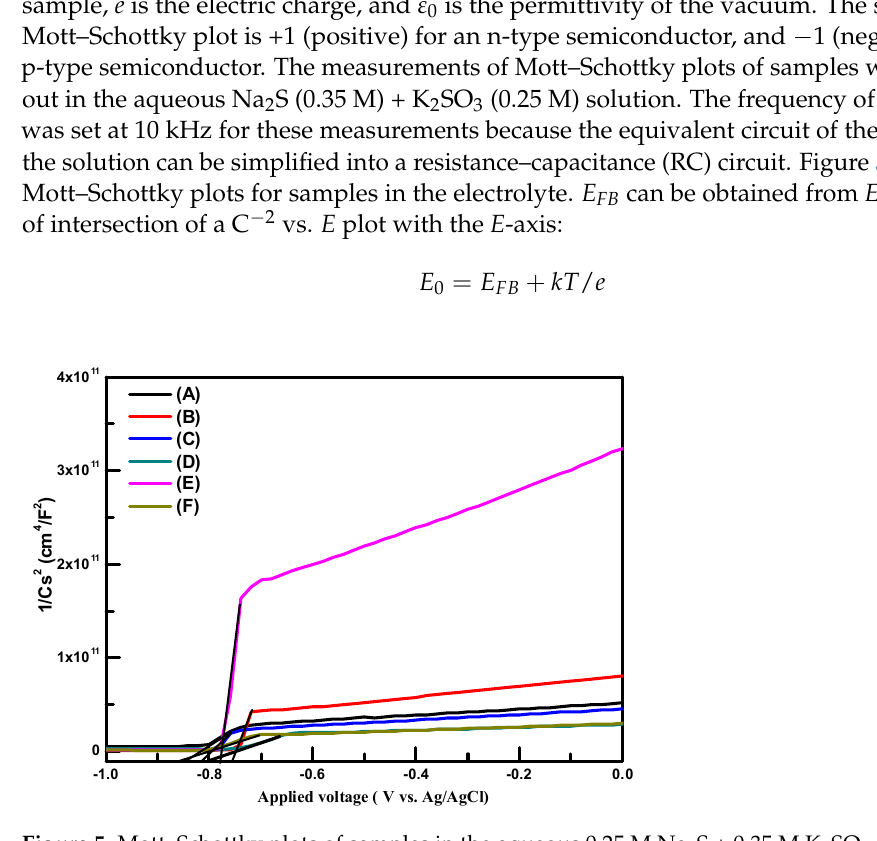
Figure 6. Band position of samples in the aqueous 0.25 M Na 2 S + 0.35 M K 2 SO 3 solution. The current density-applied voltage plots of samples A–F in the dark and under irradiation were employed to examine their PEC performances for hydrogen produc- tion. In order to compare with the PEC performances of metal sulfides reported in the literature [13,21,28,30], the aqueous 0.35 M Na 2 S + 0.25 M K 2 SO 3 solution was employed as the electrolyte. Figure 7 shows the typical current density-applied voltage measure- ments obtained using the chopping method for samples A–F with applied potentials in the range of − 1.0 V to 0.5 V vs. an Ag/AgCl electrode in the 0.25 M Na 2 S + 0.35 M K 2 SO 3 aqueous solution, respectively.